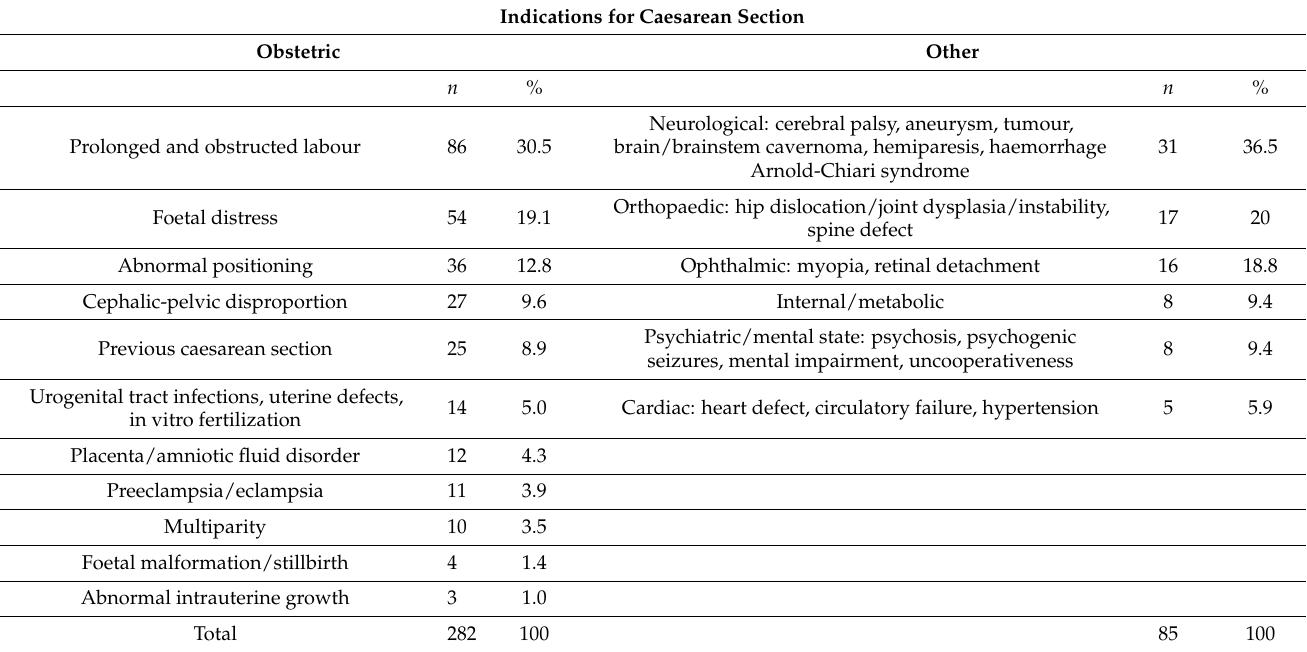
Table 3. Summary of obstetric and other than epilepsy-related indications for caesarean section. Indications for Caesarean